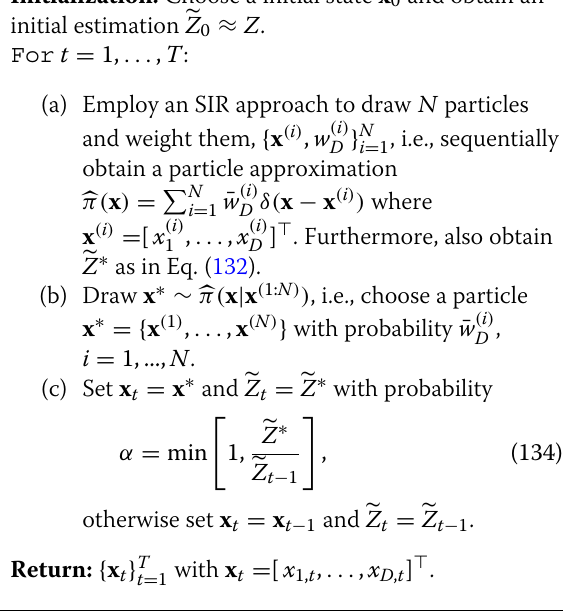
Algorithm 26 Particle Metropolis-Hastings (PMH).